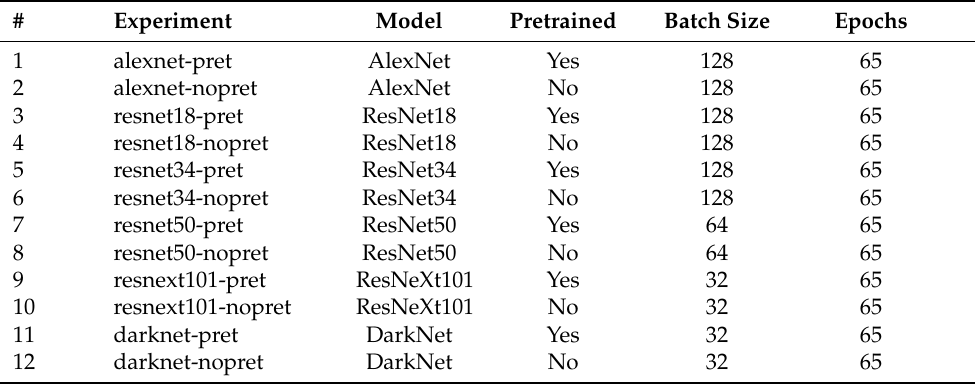
Figure 5. Average of the 10-fold validation loss for each epoch. Table 3. Experimental